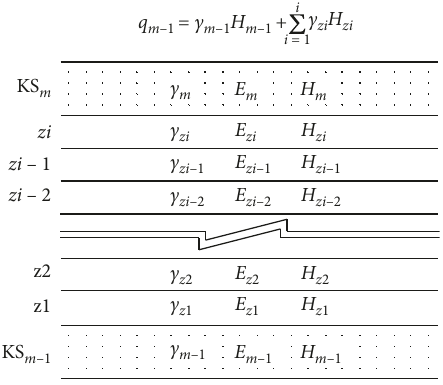
Figure 8: Diagram of adjacent